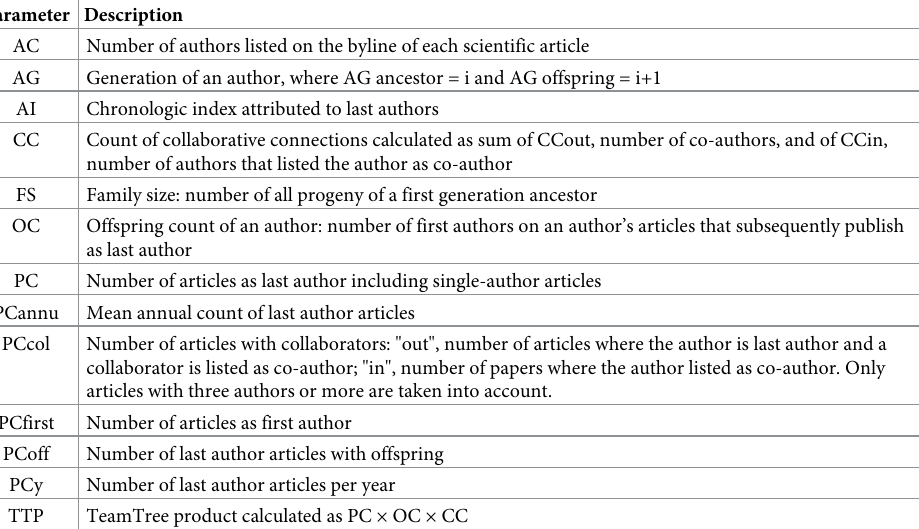
Table 1. TTA-derived